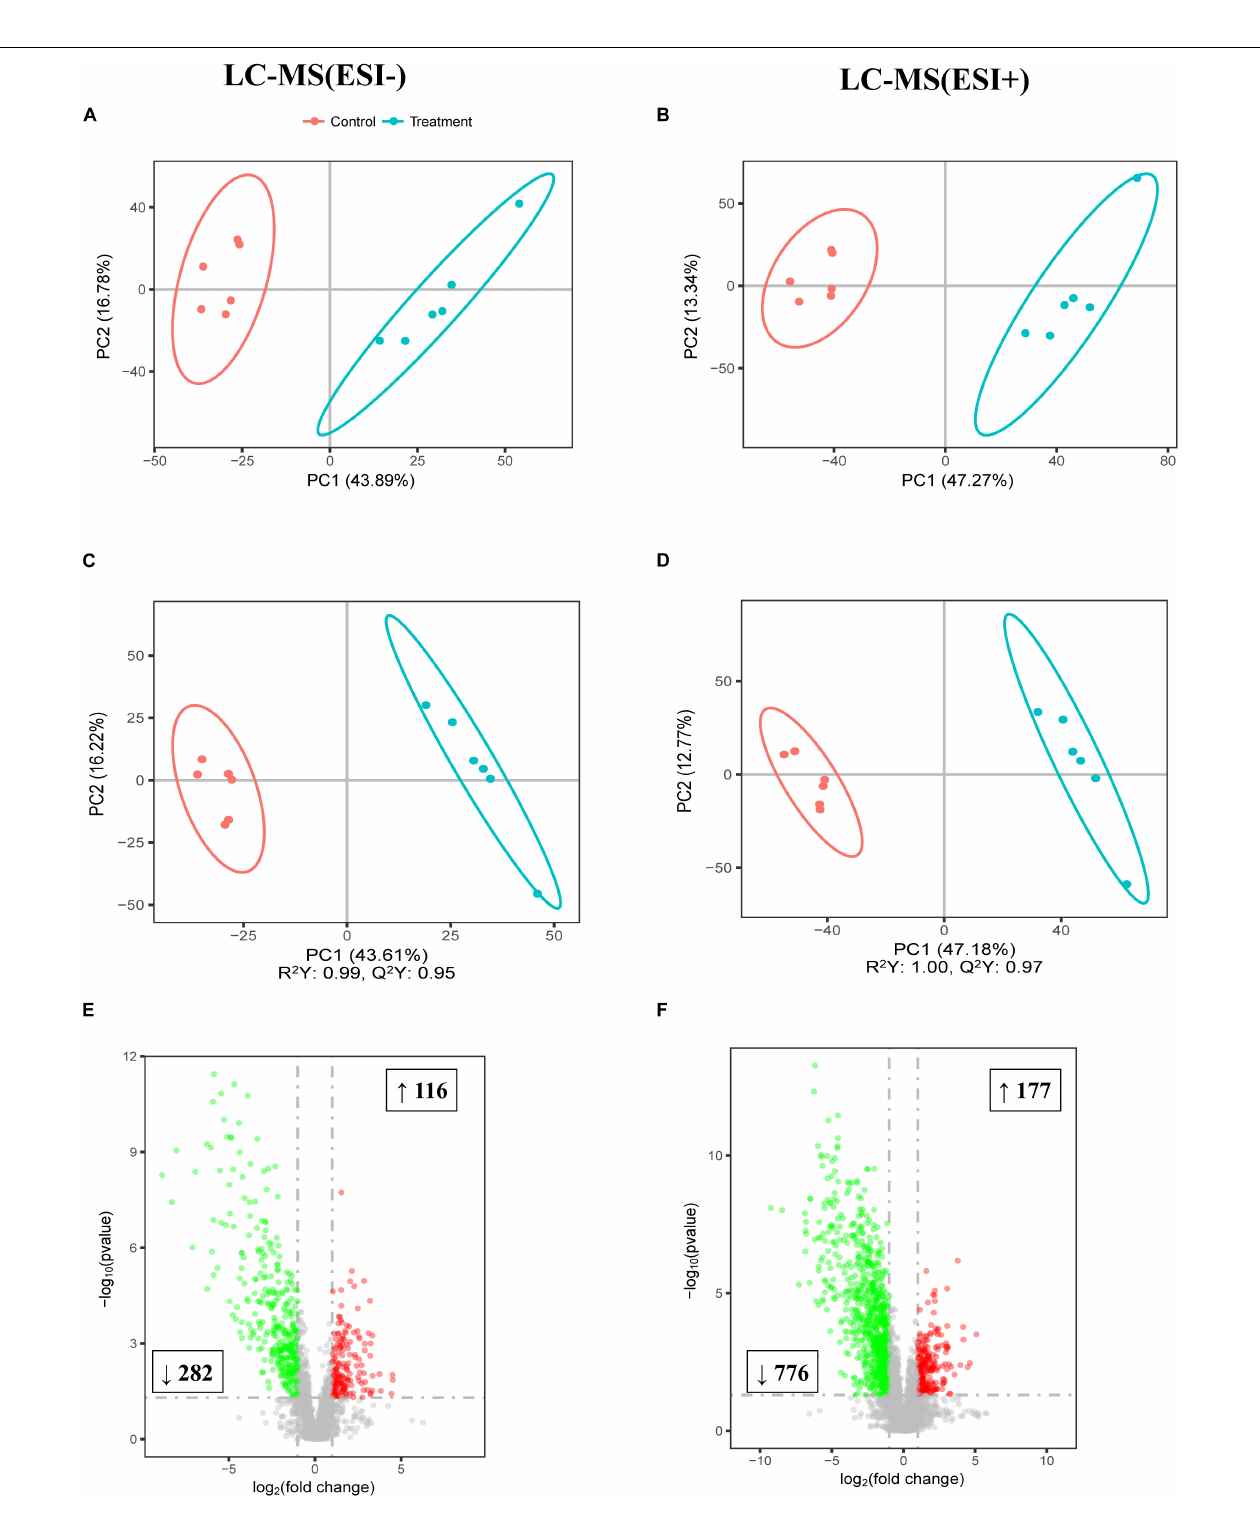
FIGURE 4 | Multivariate statistical analysis of untargeted metabolomics data obtained using the LC-MS/MS approach. PCA score plot of colonic metabolomics data for treatment (blue) and control (red) pigs obtained by (A) LC-MS (ESI − ) and (B) LC-MS (ESI+) ( n = 6). (C) PLS-DA score plot of colonic metabolomics data obtained by LC-MS (ESI − ); R 2 Y = 0.99; Q 2 = 0.95. (D) PLS-DA score plot of colonic metabolomics data obtained by LC-MS (ESI+) data; R 2 Y = 1.00; Q 2 = 0.97. (E) Score plot of LC-MS (ESI − ) data with 2,395 metabolite signals detected. (F) Score plot of LC-MS (ESI+) data with 5,708 metabolite signals detected. Red circles in volcano plots are model-separated metabolites following the conditions of VIP > 1 and | P(corr)| ≥ 0.5 with 95% jack-knifed confidence intervals. Red or green rectangles indicate the numbers and tendency of metabolites to separate in the model when FF group pigs are compared with UF group.